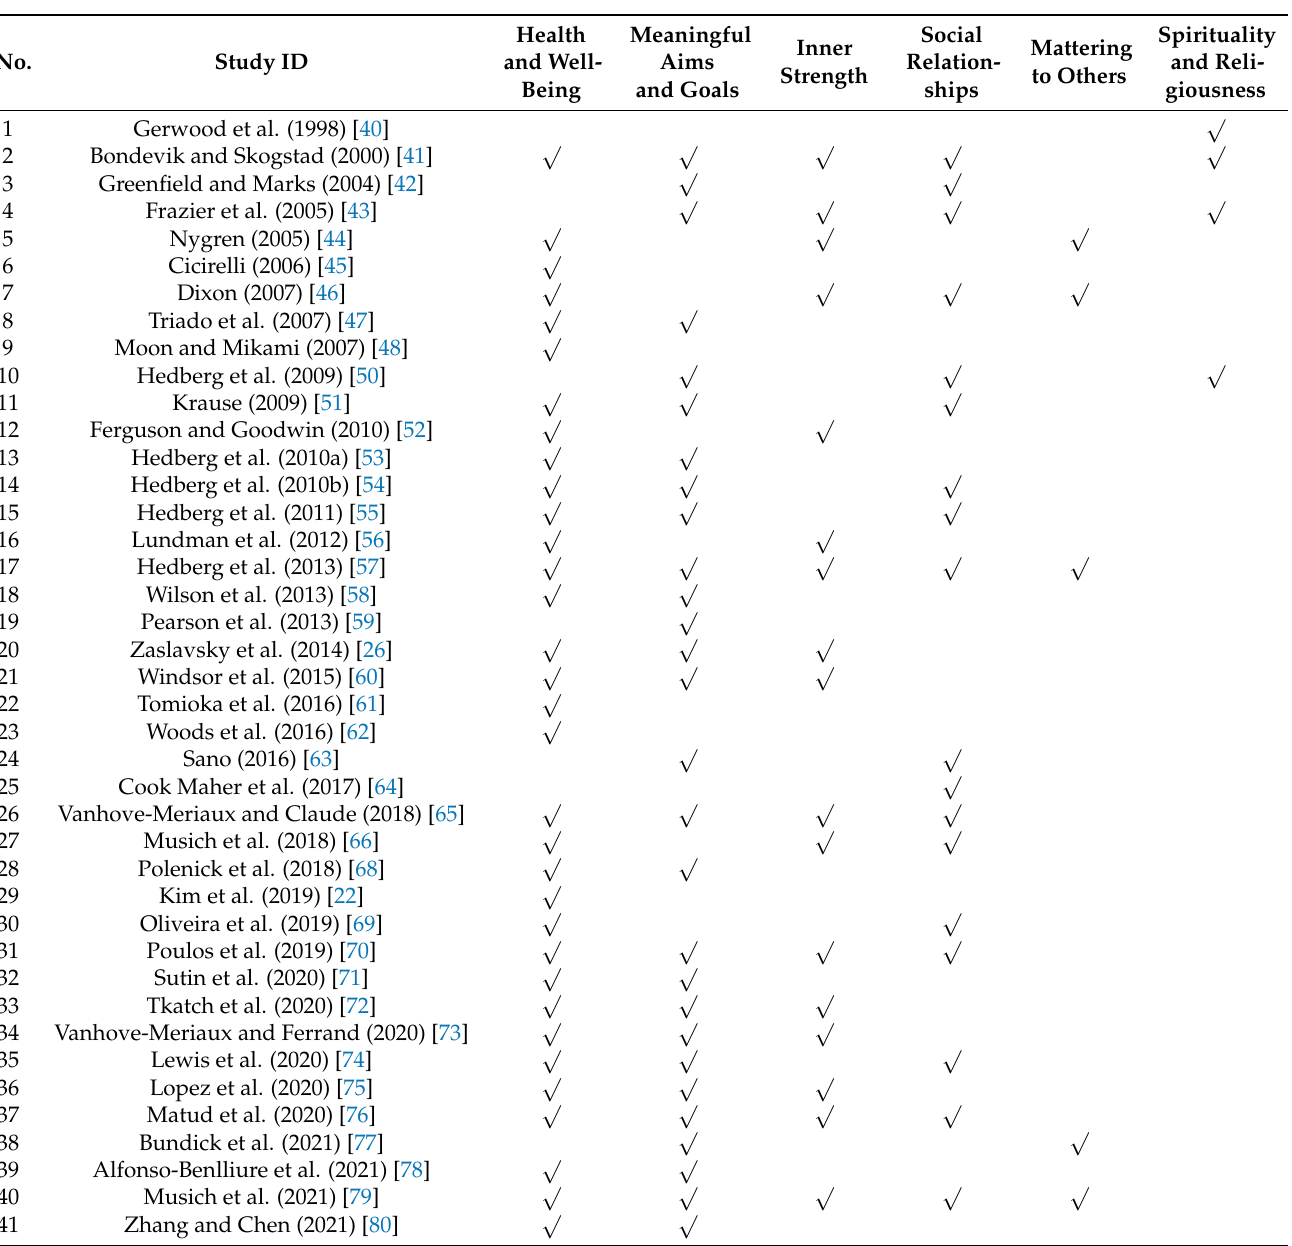
Table 2. Citations and their conceptualization of